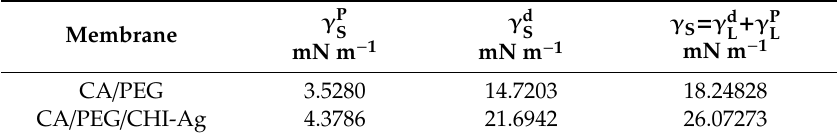
Table 3. Surface free energy (SFE) and its polar and dispersive components for obtained polymeric